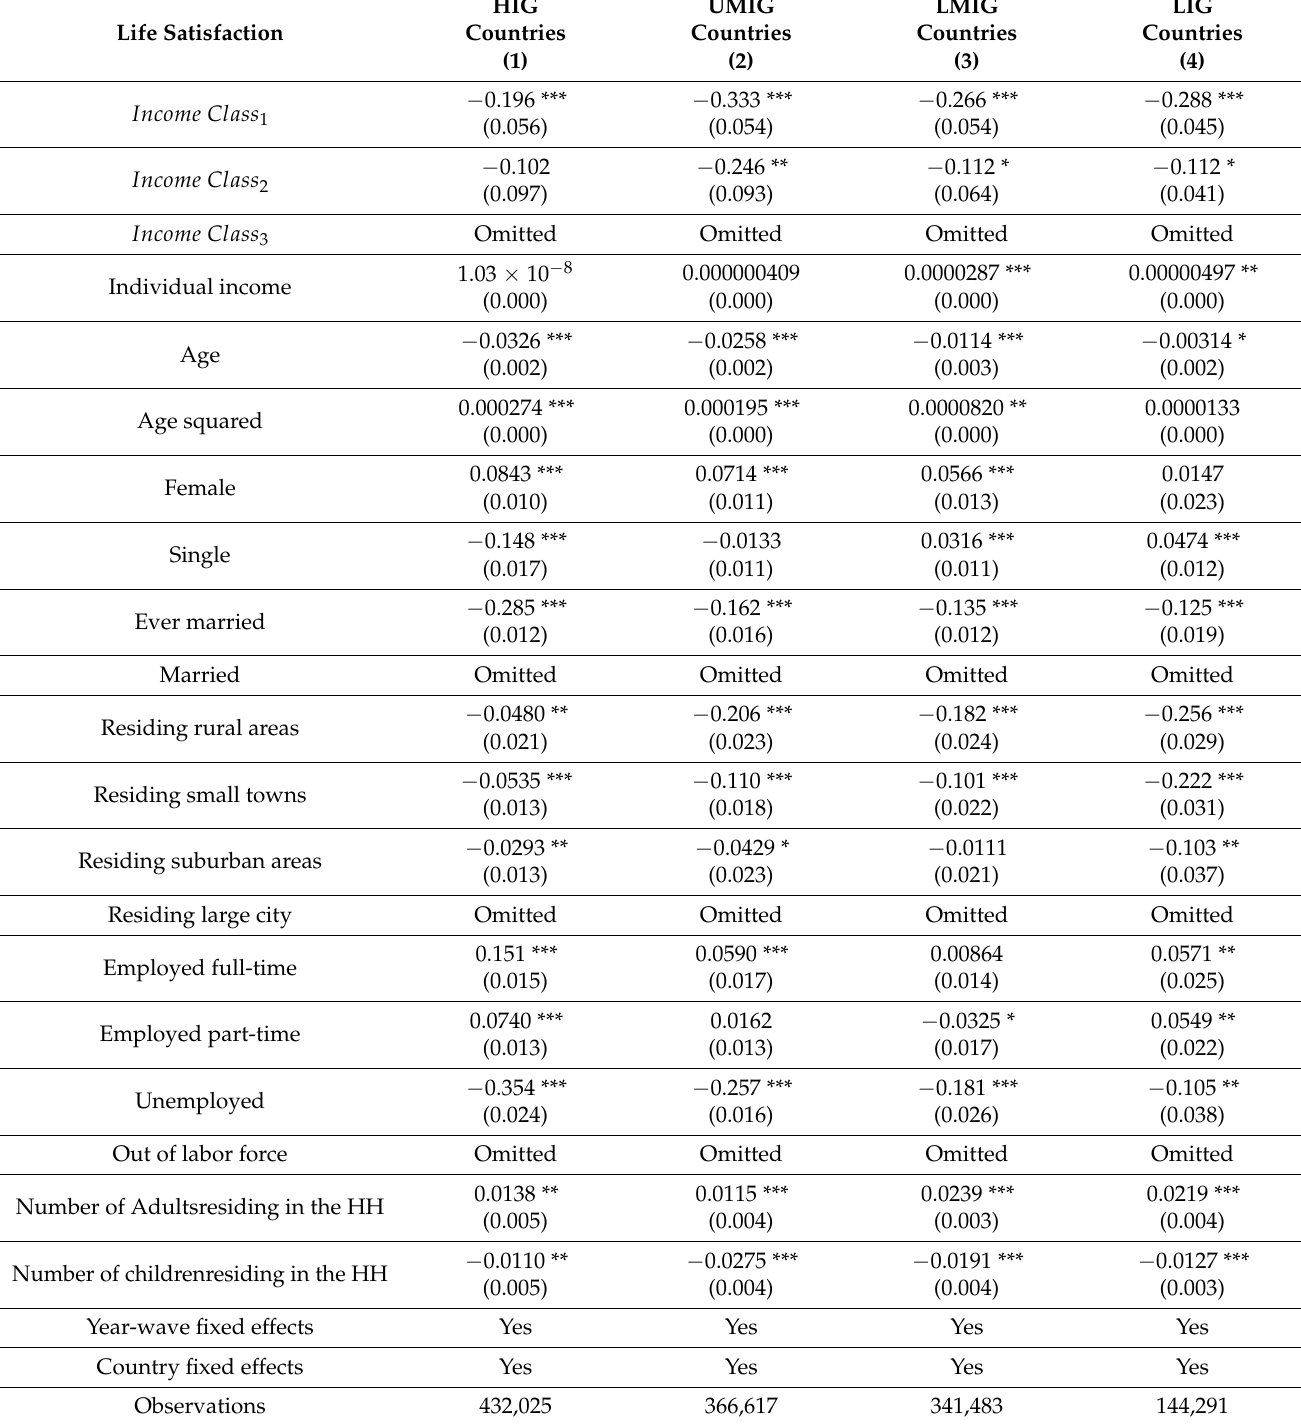
Table 5. Heterogeneity analysis: by income country